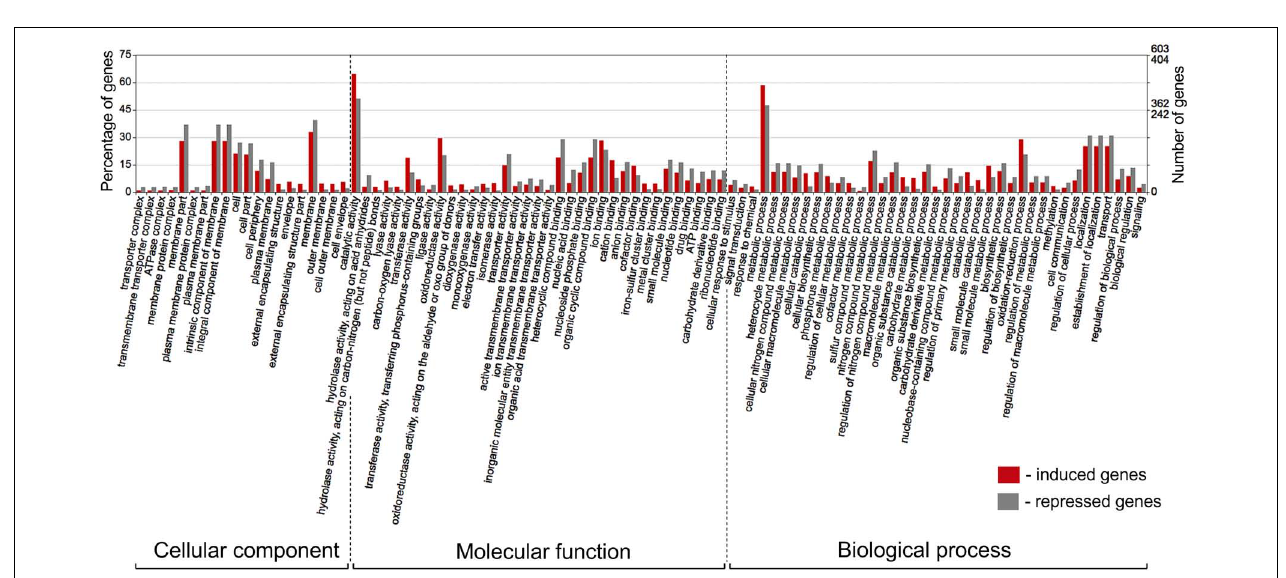
FIGURE 5 | Comparison of the eight Pseudomonas strains based on the content (presence/absence) of genes differentially expressed in the presence of root exudates. (A) UPGMA clustering based on the Sorensen’s dissimilarity index. (B) non-metric multidimensional scaling (NMDS) analysis.